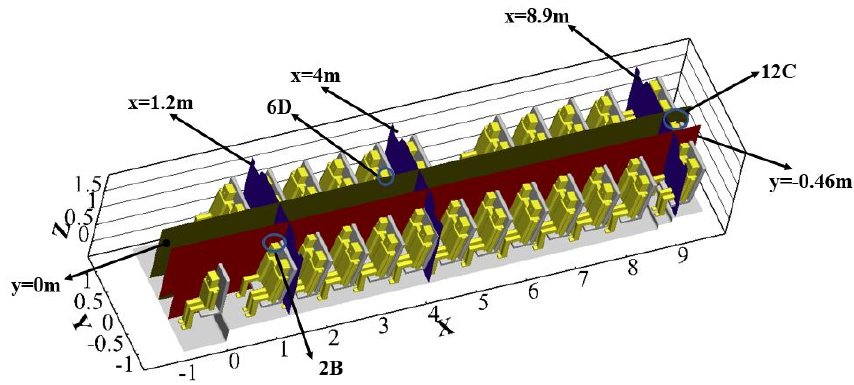
Figure 7. Time variation of particle-number density at point 1 for 8.5 µ m particles.